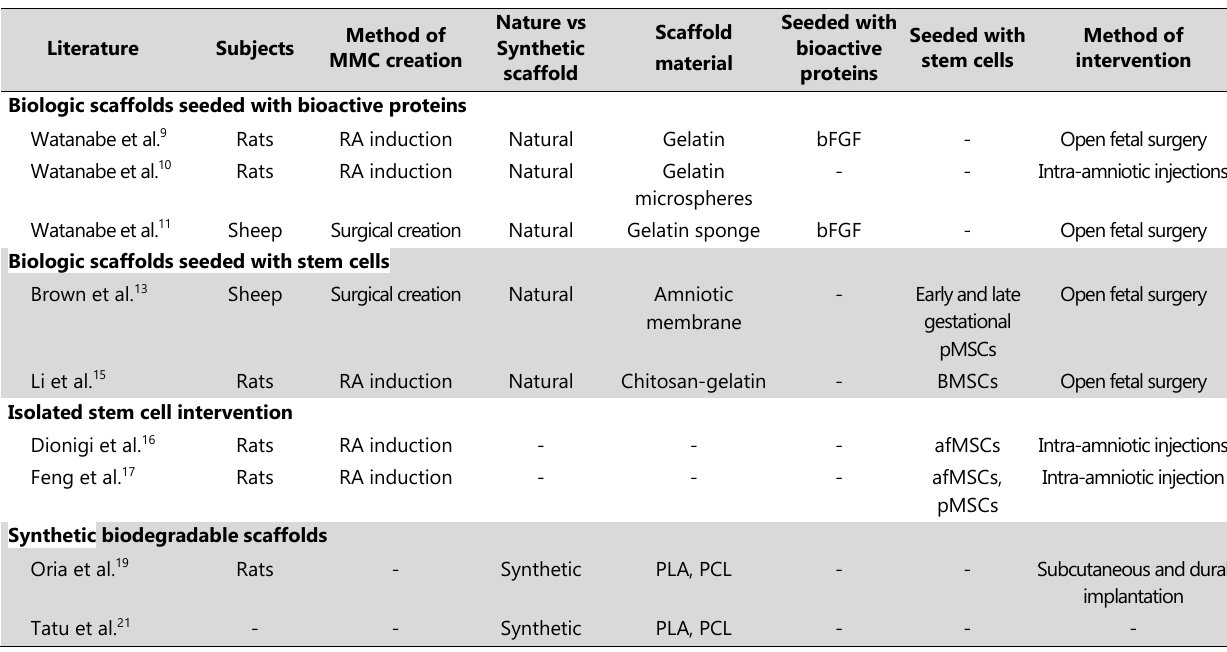
Table 3 . Summary of the Biomedical Engineering Study Methods Used by Various Groups to Improve Upon Standard Treatment of Myelomeningocele in the Post-MOMs Era.